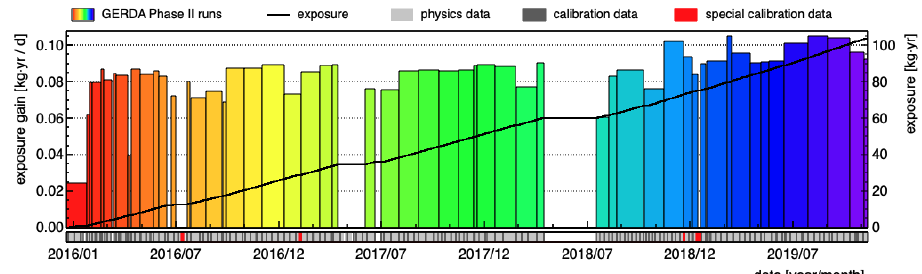
Figure 16. The evolution of the Phase II data-taking and exposure.